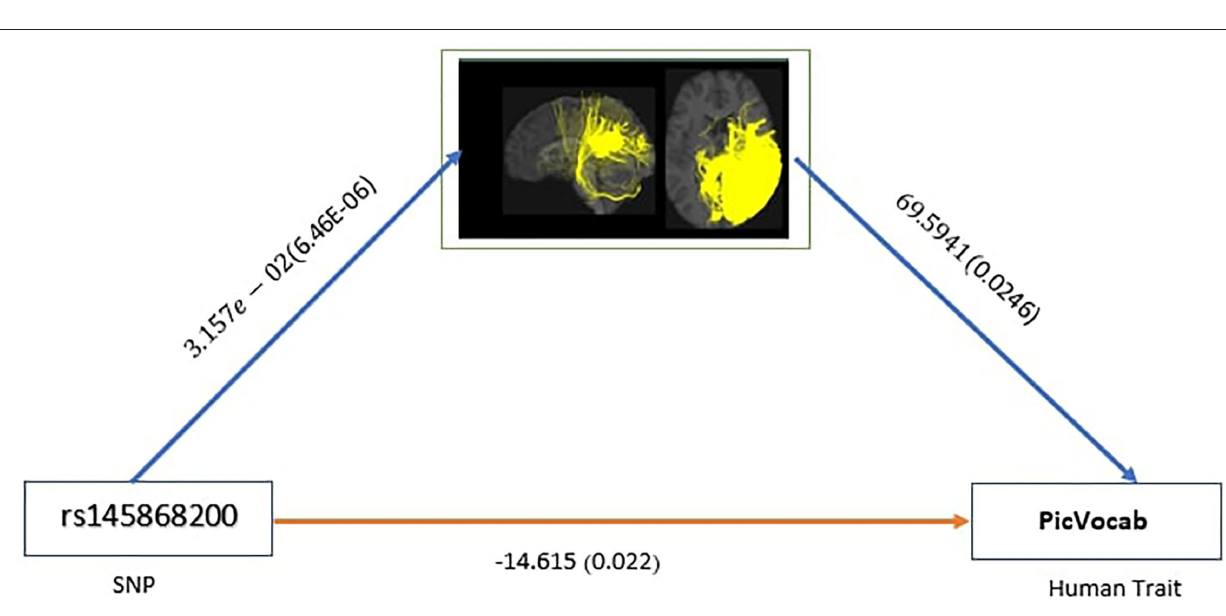
determine the significance of indirect effect of each selected SNP on human